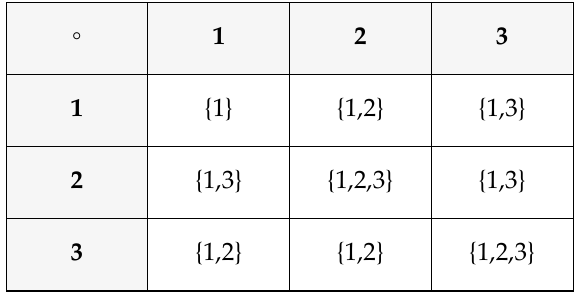
Table 20. Transposition polysymmetrical left almost-hypergroup.